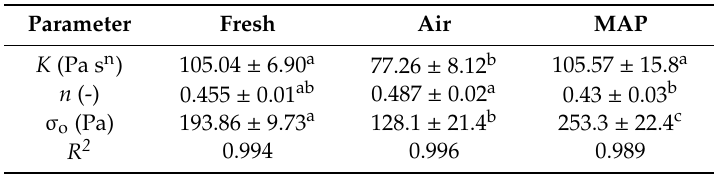
Table 7. Rheological characterization of mashed broad beans at day 0 (fresh) and after 7 days of storage in air and MAP follow up MW re-heating (70 ± 5 ◦ C). Values in the same row with di ff erent letters are significantly di ff erent (Tukey’s LSD, p < 0.05).